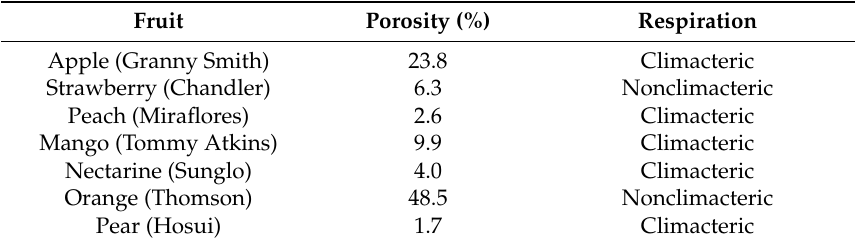
Table 1. Porosity of some climacteric and nonclimacteric raw fruits [24–26]. Fruit Porosity